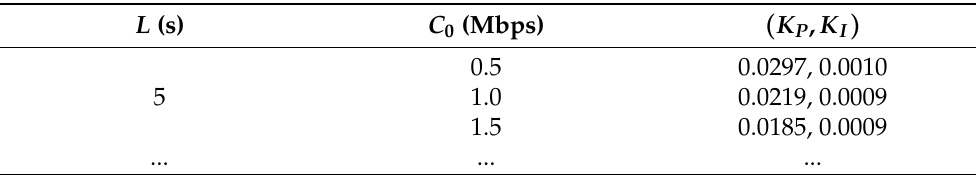
Table 2. Control Gain Table ( ρ = 10 4 ).